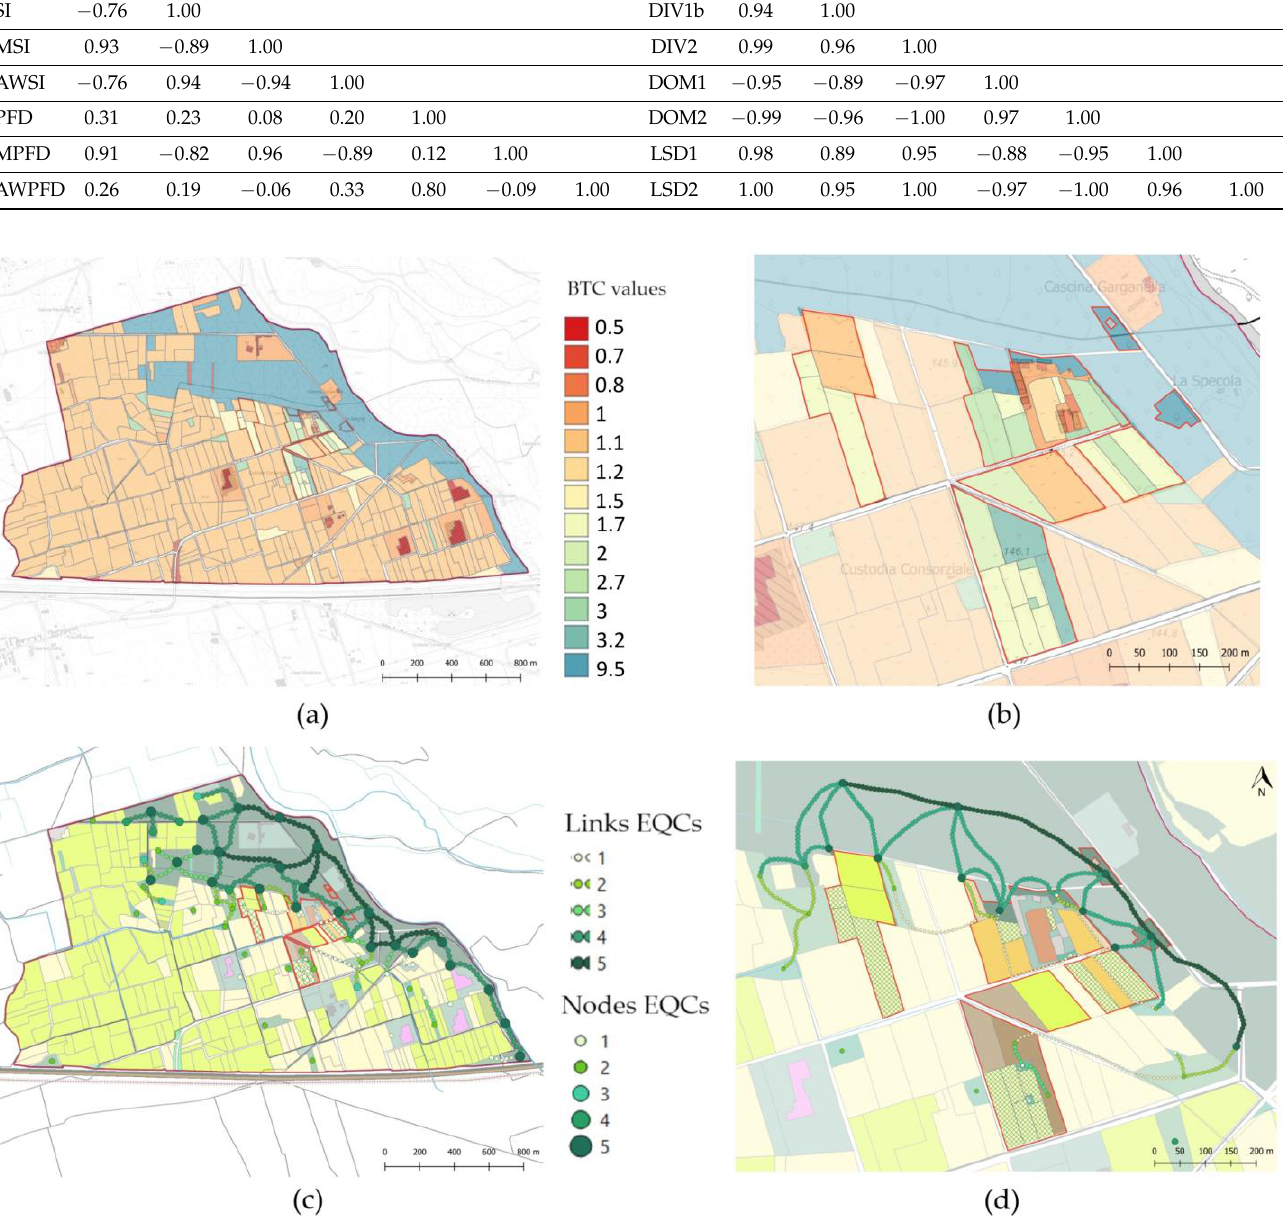
Figure 5. ( a , b ) Spatial distribution of BTC values related to the land use patch categories at local ( a ) and farm ( b ) scales; ( c , d ) spatial configuration of links and nodes at local ( c ) and farm ( d ) scales, showing their belonging to the different Ecological Quality Classes (EQC s ).